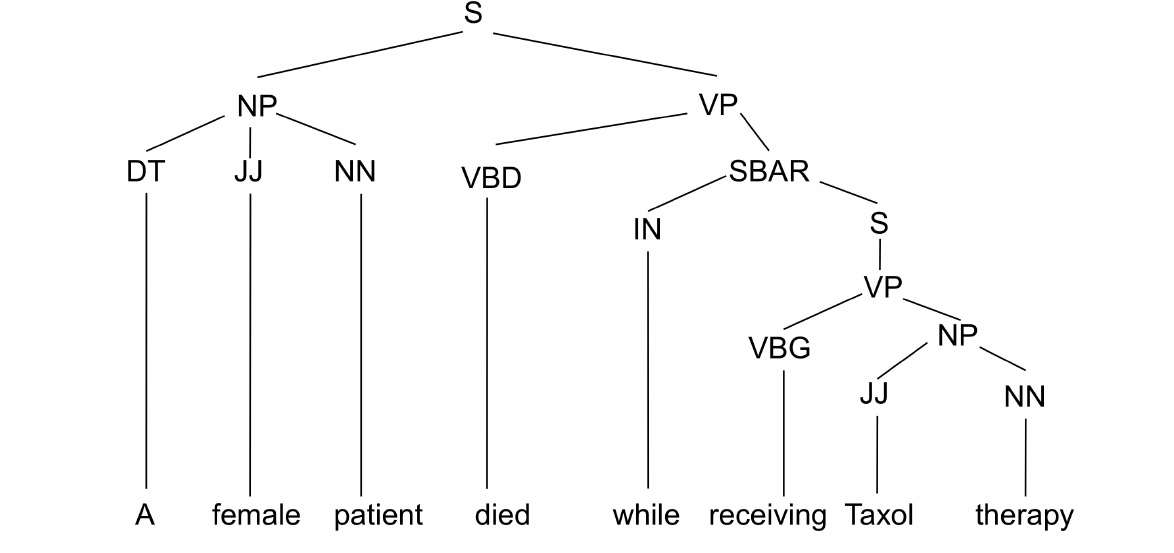
Figure 2. The sample constituency parse tree. S: simple declarative clause, NP: noun phrase, VP: verb phrase, DT: determiner, JJ: adjective, NN: noun, VBD: verb, past tense, SBAR: subordinate clause, IN: preposition or subordinating conjunction, VBG: verb, gerund or present